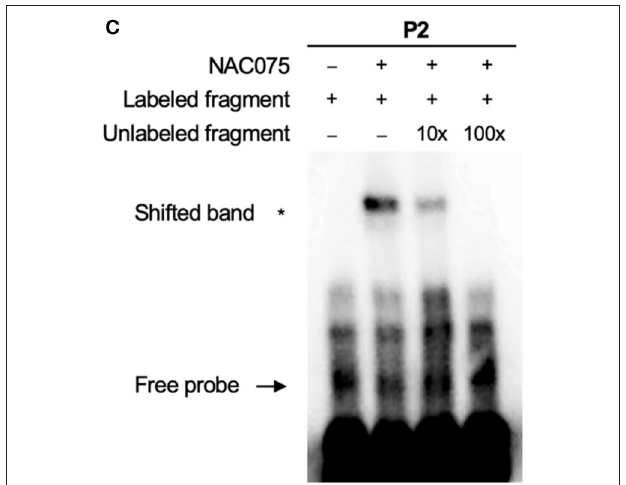
FIGURE 4 | (C) EMSA assay of the binding of NAC075 to the CAT2 promoter in vitro . Biotin-labeled probe was used to EMSA experiment and non-labeled fragments were used as competitors. The + and − symbols represent the presence and absence of components. Three biological replicates were performed with similar